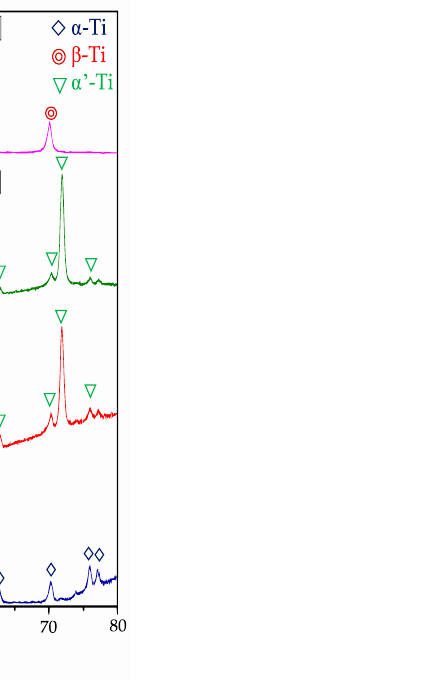
Figure 4. XRD patterns after sintering of Ti and composites with 20, 25 and 30 wt.% of Ta.